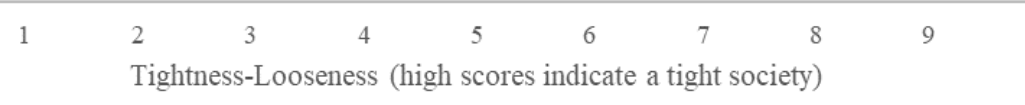
Figure 3. Relation between Tightness-Looseness and Preference for professional medical help in non-acute medical situations. The graph suggests a linear relation between Tightness-Looseness and the number of times professional medical help is preferred in the case of mild medical conditions (headache, stomach-ache, back-pain and sleeping problems). Tightness-Looseness is not related to GDP per capita as both Turkey (emerging economy) and Norway (highly developed economy) are both tight societies and Ukraine, a comparable economy to Turkey, has a low tightness.